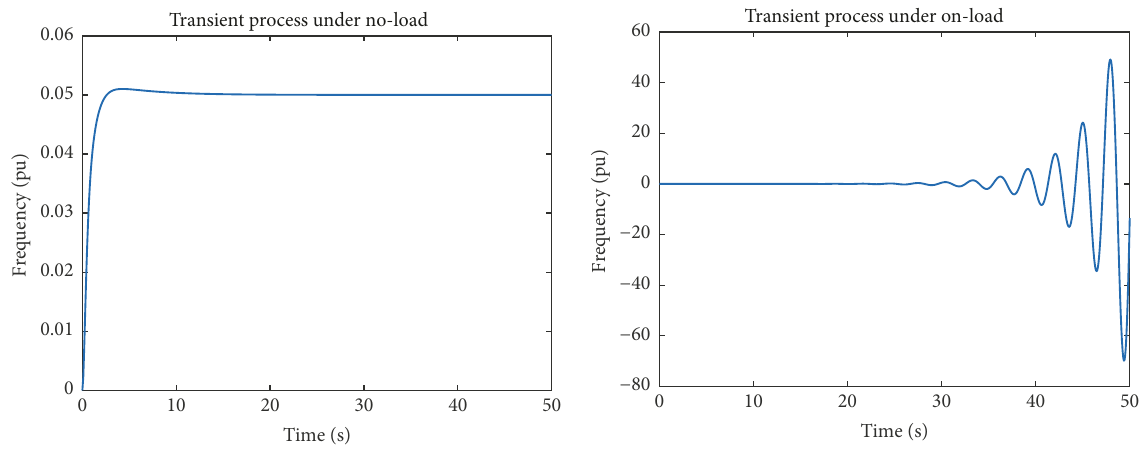
Figure 3: Transient process by different control